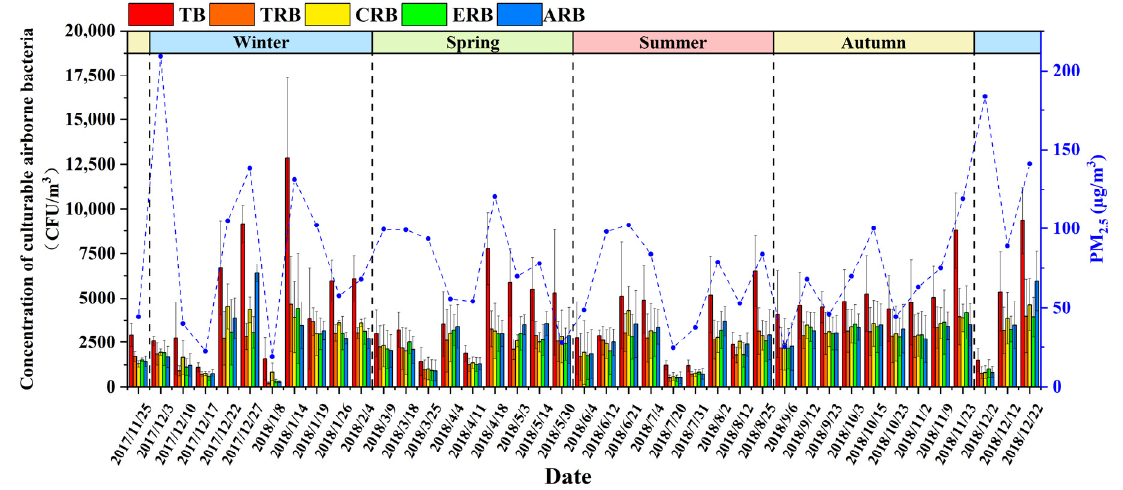
Figure 1. Variation of airborne bacteria, antibiotic-resistant bacteria, and PM 2.5 during sampling days.